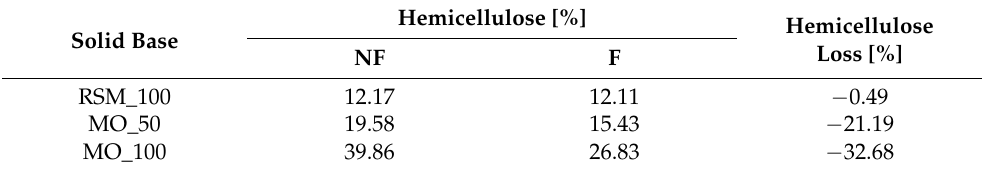
Table 2. Hemicellulose content of SSF medium used in the study. RSM—rapeseed meal, MO (milled oats) followed by a number specifies the level of RSM replacement by MO, NF—non-fermented, F—fermented. Hemicellulose loss is calcu- lated as (NF – F)/NF in percent.